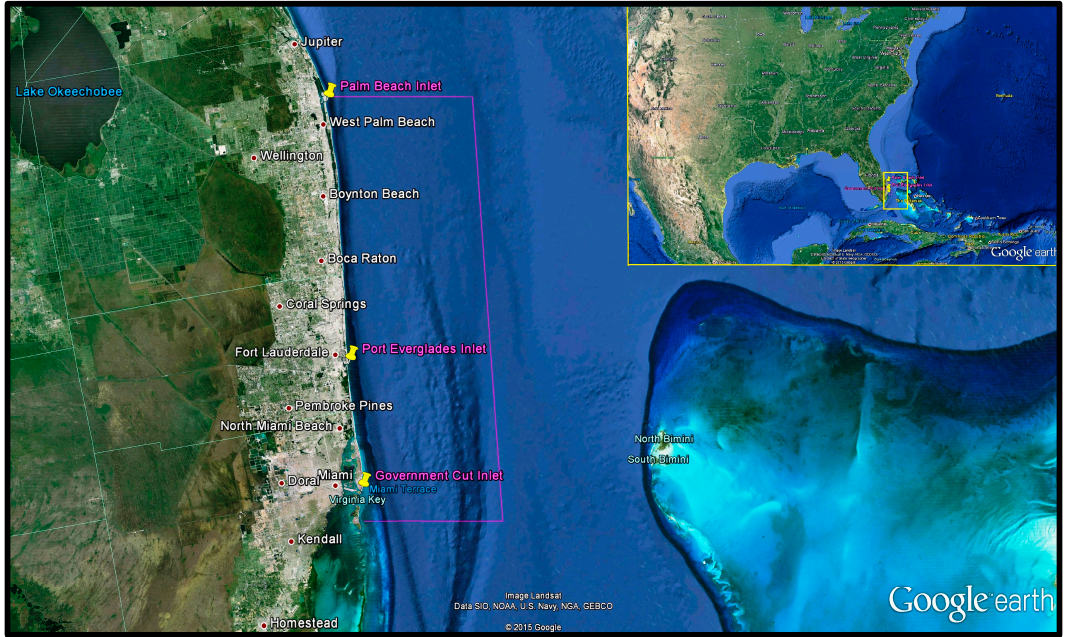
Figure 8. Study area. Recreational swordfish fishing ports off South Florida (USA). The pink boundary line designates the main swordfish grounds; Florida Straits [27]. Google Earth map based on Landsat image, and data from SIO, NOAA, United States Navy, NGA and GEBCO.